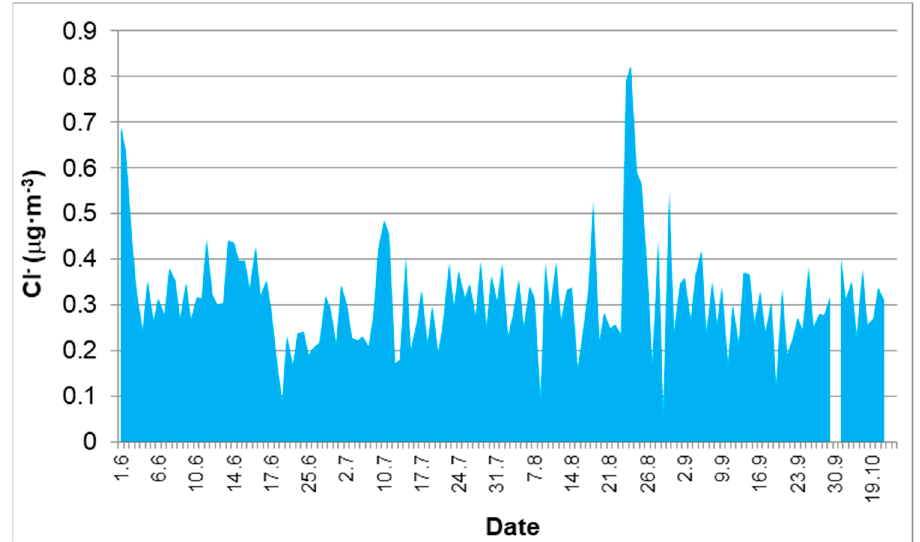
Figure 6. Variability of the Cl − concentrations in the atmospheric aerosol in the air at the Bolshiye Koty research station in 2020, μ g/m 3 .